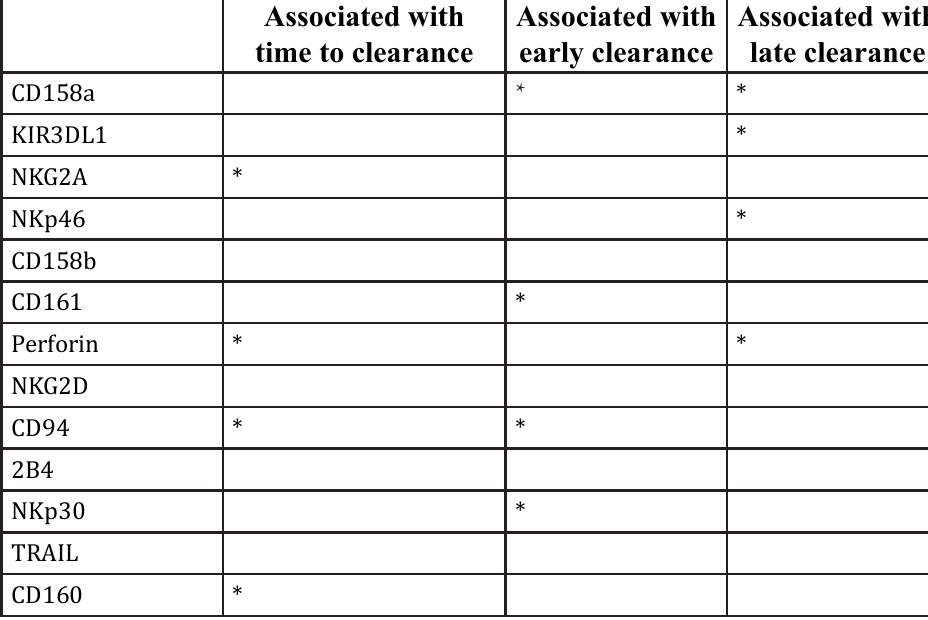
Table 2. CD56 dim NK-cell phenotype alteration in acute HBV and association with HBsAg Clearance